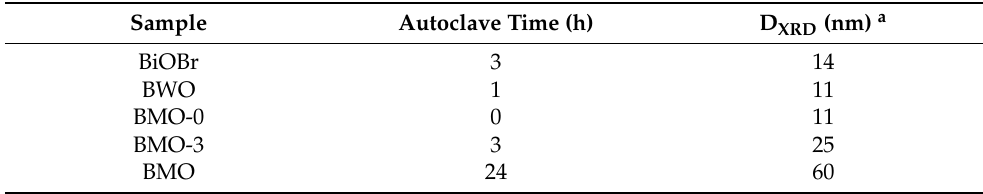
Figure 2. Crystallites size analysis of ( A ) BWO and ( B ) BMO with Williamson–Hall method. Table 1. Mean dimensions of crystallites (<DXRD>) are calculated from full width at half maximum (FWHM) of X-ray diffraction peaks a of BiOBr and BWO.